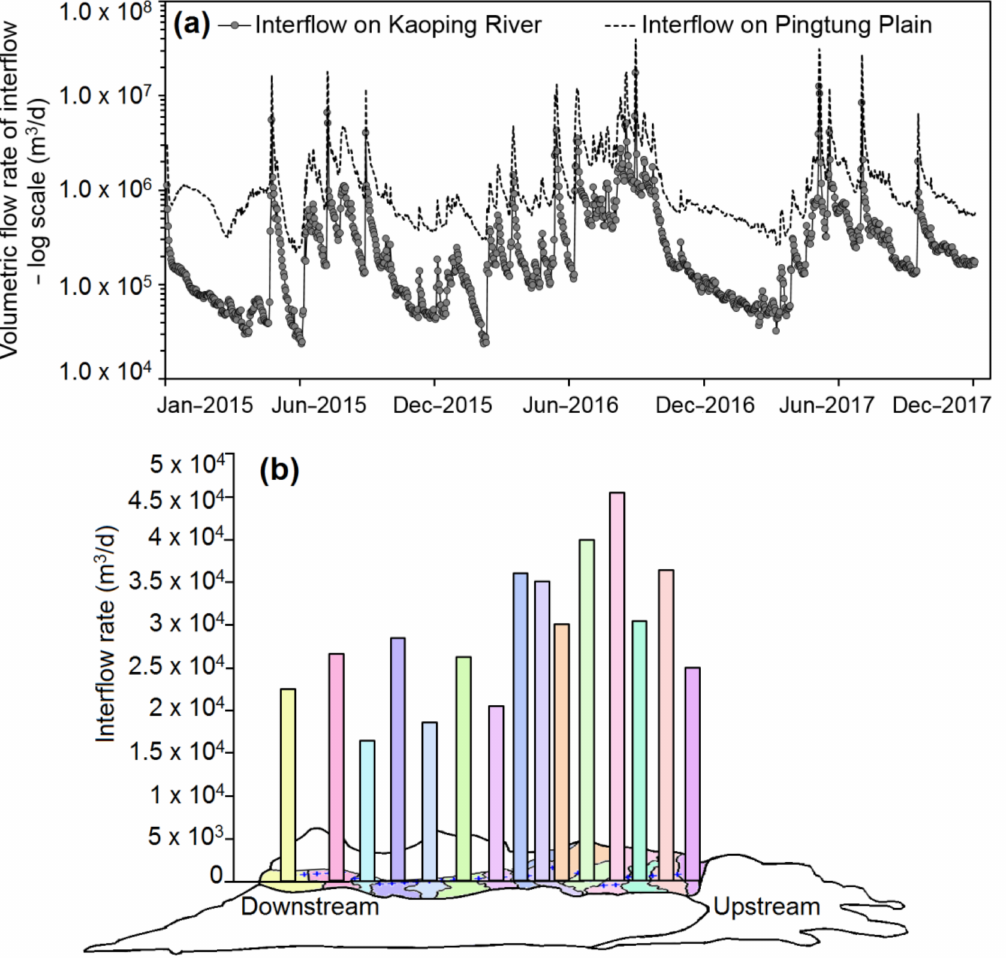
Figure 9. The simulated interflow volumetric rates: ( a ) a comparison of the temporal interflow variations obtained from the sub-model and the entire PPGB, ( b ) the averaged interflow rates for the HRUs along the Kaoping River obtained from the GSFLOW